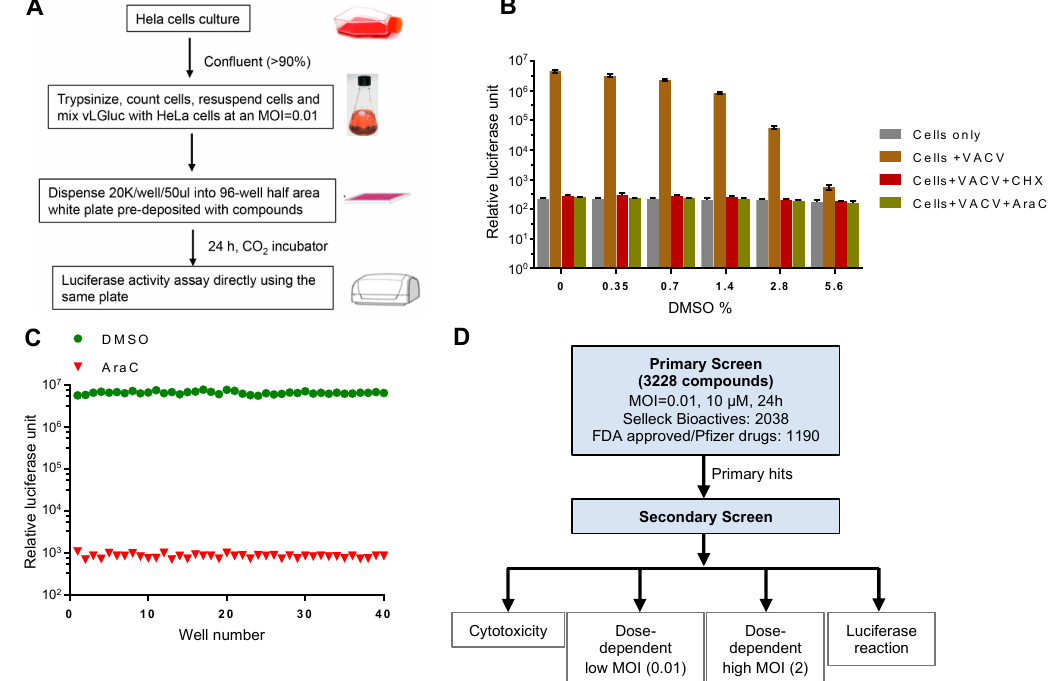
Figure 1. Experimental design and optimization of the screening procedure. ( A ) Experimental procedure for the luciferase reporter assay. ( B ) Effect of DMSO on the reporter assay. HeLa cells were infected with vLGluc at 0.01 PFU / cell in the presence or absence of cycloheximide (CHX) or cytosine arabinoside (AraC). DMSO was added to each well to reach the indicated final concentrations ( v / v ). Luciferase activities were measured 24 hours post infection (hpi). Error bars indicate standard deviation (n = 3). ( C ) HeLa cells from 40 wells in a 96-well plate at 90% confluency were infected with vLGluc at 0.01 PFU / cell in the presence of only DMSO or AraC diluted in DMSO. Luciferase activities were determined at 24 hpi. ( D ) Flowchart illustrating two rounds of screenings performed. MOI: multiplicity of infection.